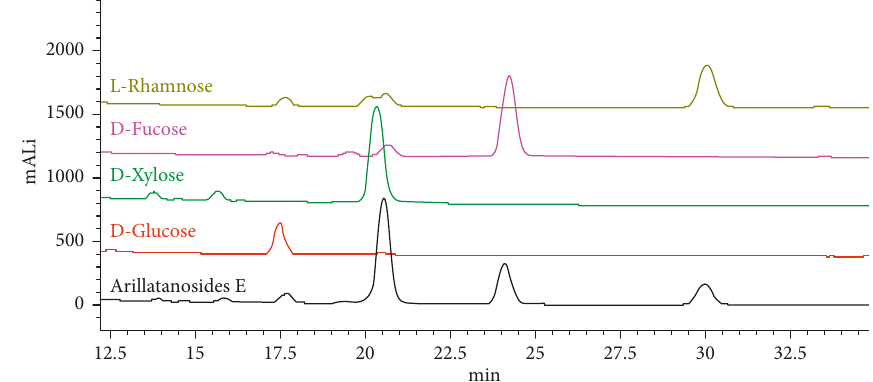
Figure 3: The hydrolyzed sugar’s identification chromatogram of compound 1